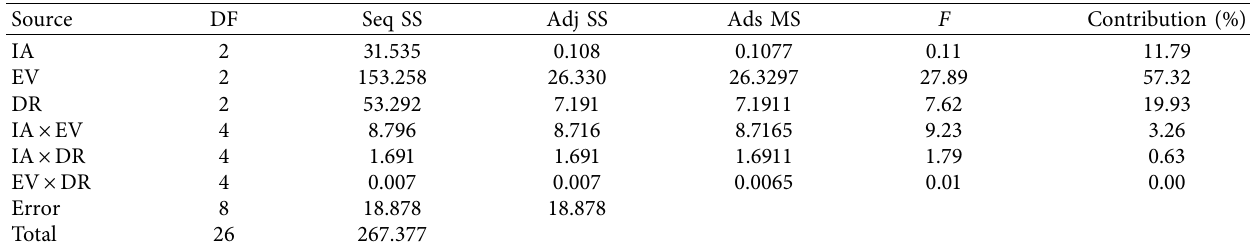
Table 7: Analysis of variance observation.